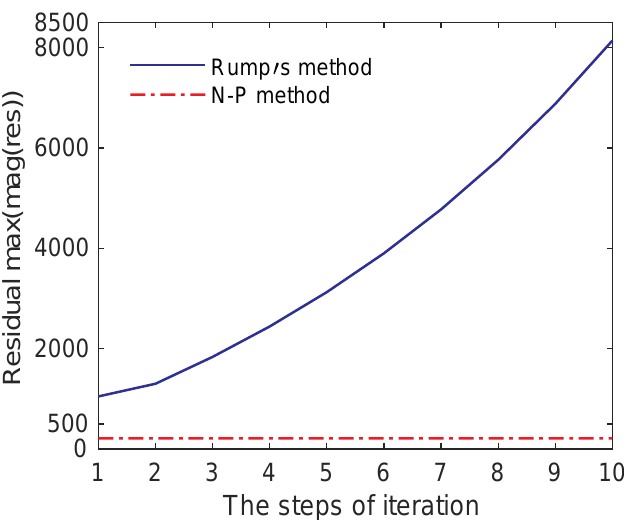
Figure 17. The comparison of the residual convergence by Rump’s method and Neumaier–Pownuk method.